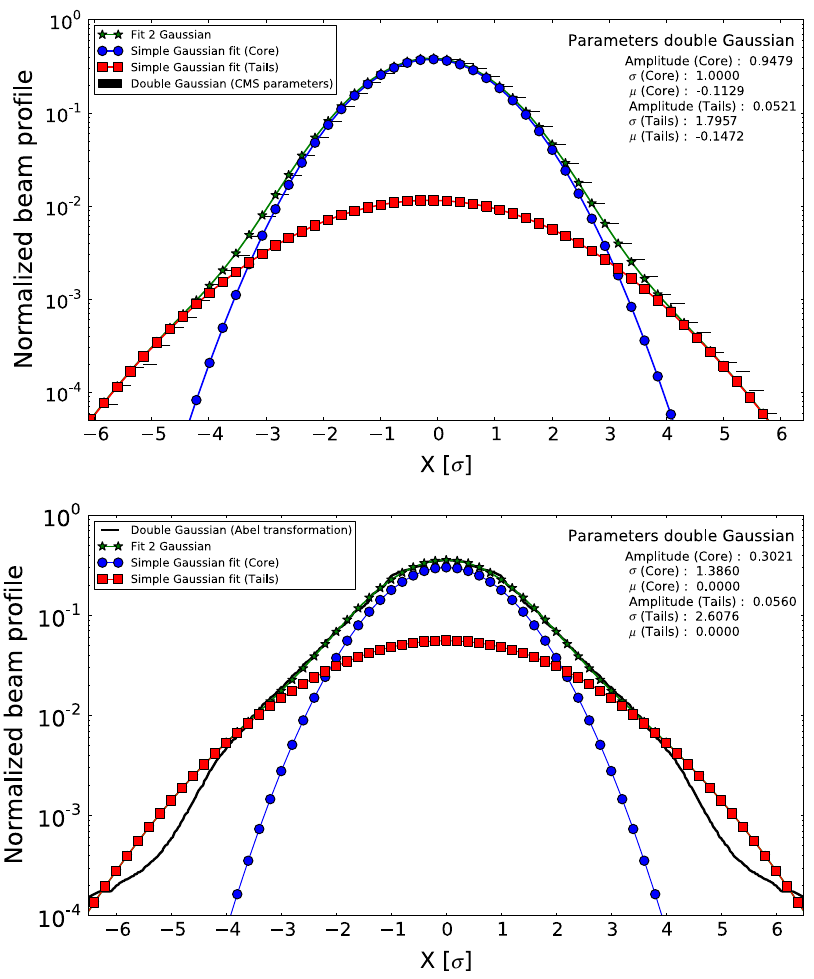
FIG. 3. The normalized horizontal beam profile extracted from data of LHC measurements. In the top, the beam distribution generated using the Van der Meer scans at CMS [28] (DG I) and in the bottom, the beam distribution obtained by applying Abel transformation to the scraping measurements [29] (DG